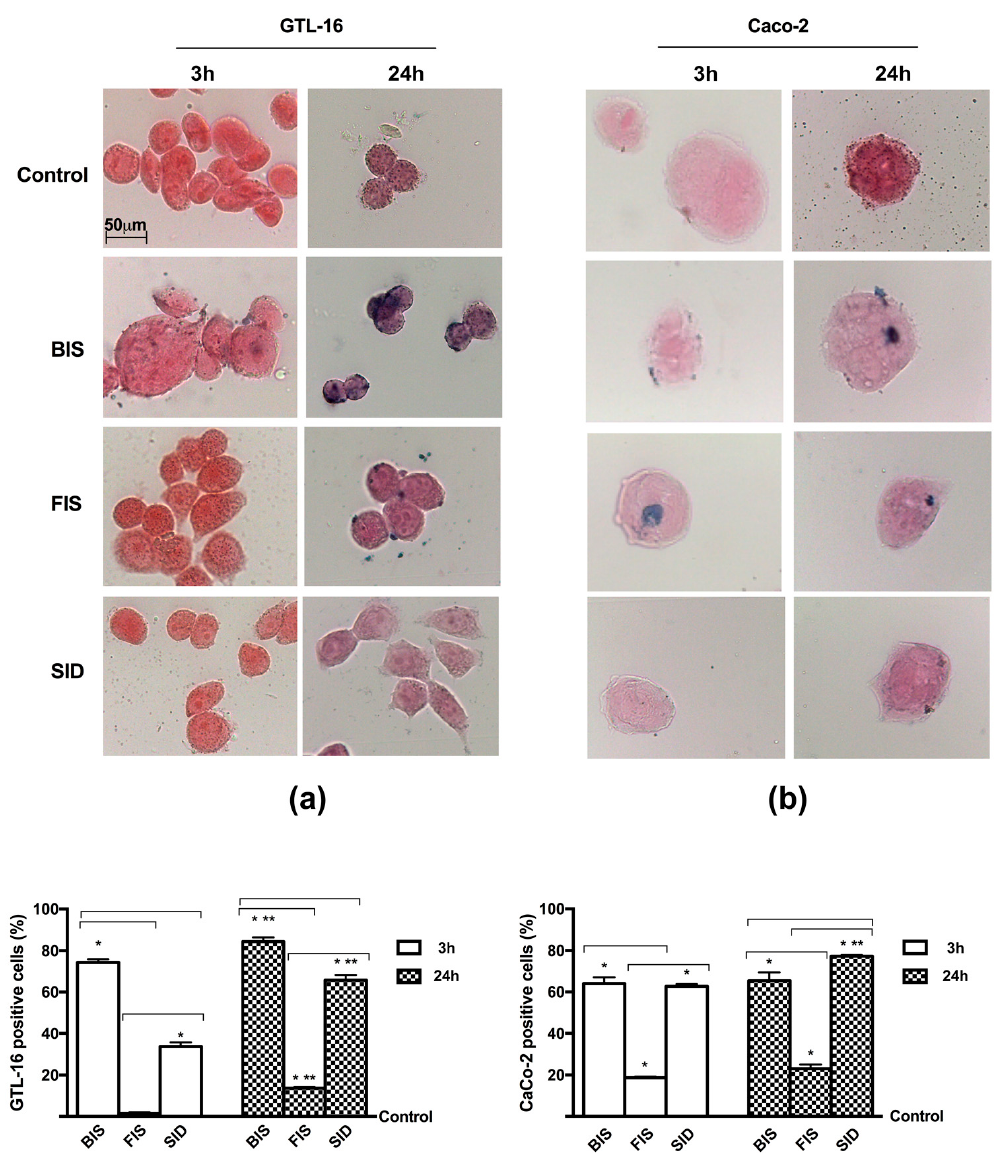
Figure A2. Turnbull staining on GTL-16 ( a ) and Caco-2 cells ( b ) treated with different iron formulations at 3 h and 24 h. ( top ) the images reported are an example of four independent experiments taken at original magnification 40 × . The scale bar in the first image can be used for all others; ( bottom ) the positive cells counted were obtained from four independent experiments and expressed as means ± SD (% vs. control). * p < 0.05 vs. control; ** p < 0.05 vs. correspondent column at different times; bars p < 0.05 among different treatments at the same time.